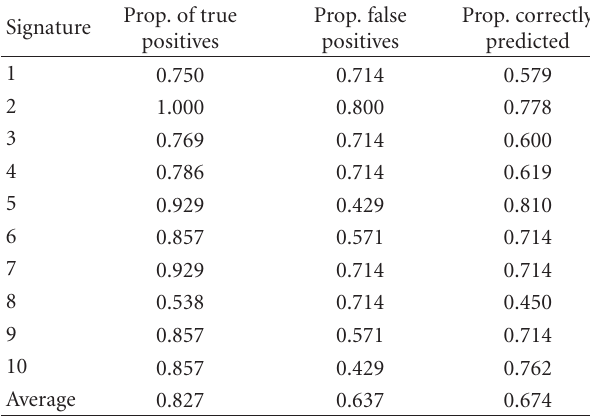
Table 3: Unbiased estimators of prediction performance for the ten signatures estimated on the validation sets.